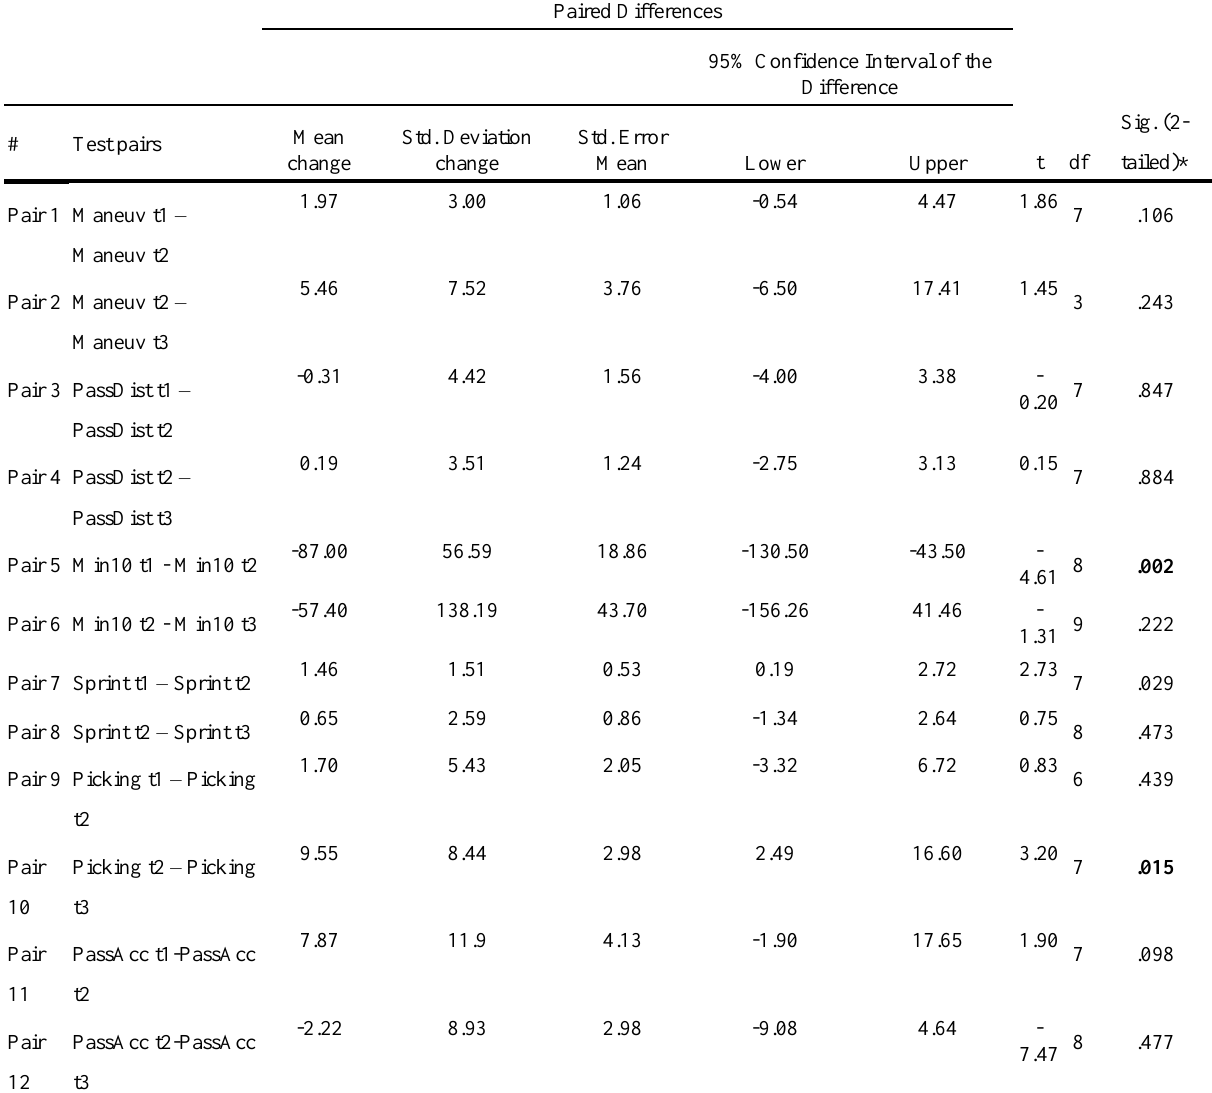
Table 4 Paired differences and significance of t-tests performed across tests and